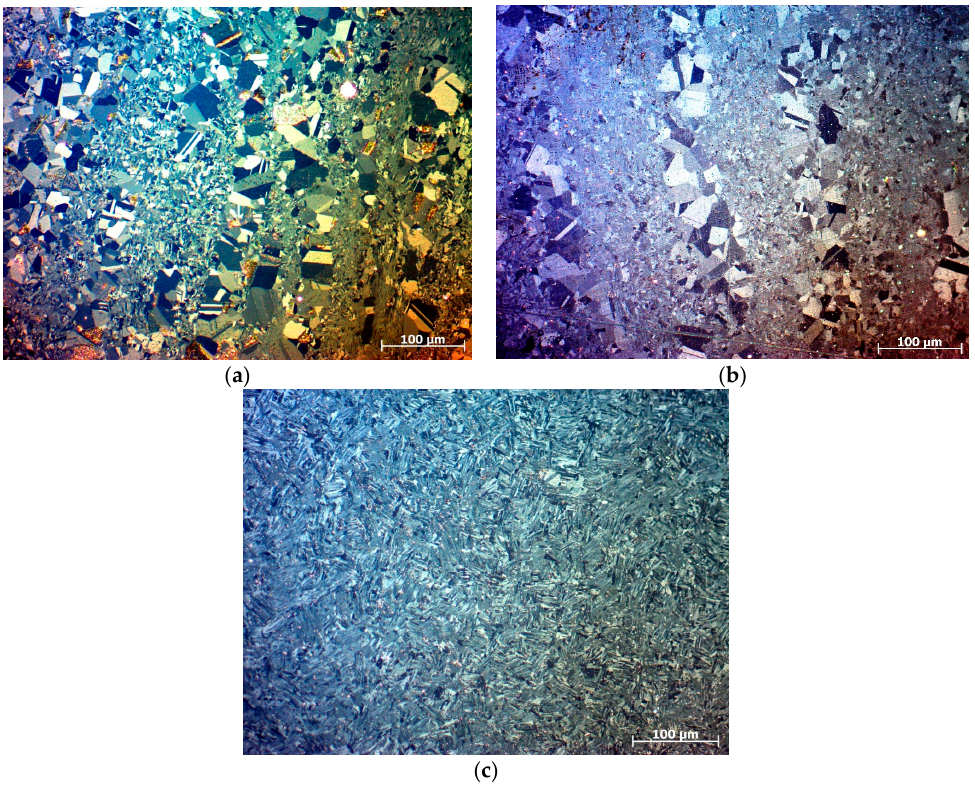
Figure 4. Cross-sectional microstuctures of γ -TiAl samples produced using of low energy ( a ); medium energy ( b ); and high energy ( c ) inputs. The build orientation is from bottom to top.